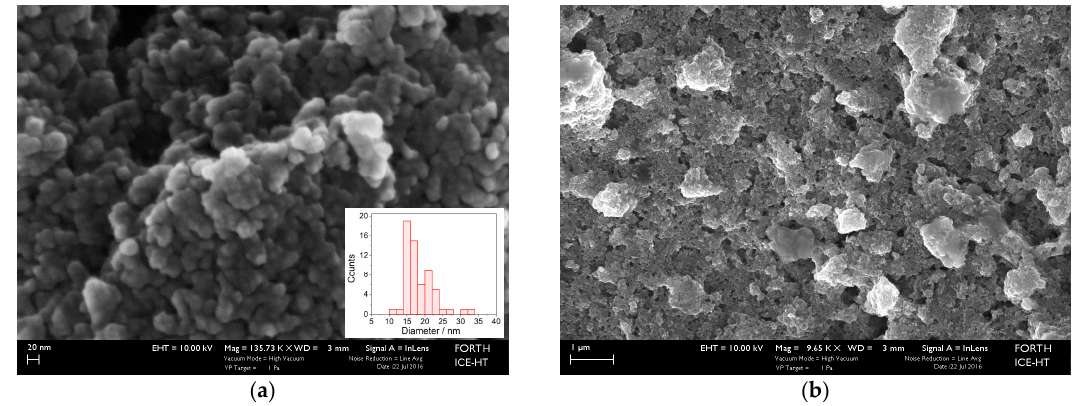
Figure 4. SEM images: ( a ) high magnification showing individual ZnO nanocrystals; and ( b ) a surface view of the obtained ZnO layer, after six depositions. Insert in image ( a ) shows particle size distribution.